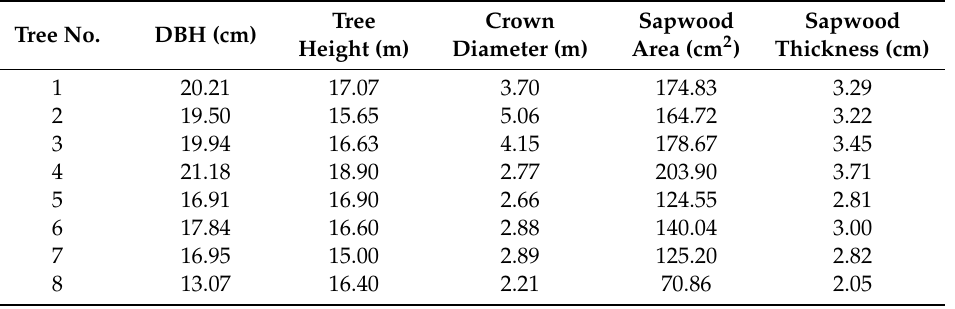
Tree Crown Sapwood Sapwood Height (m) Diameter (m) Area (cm 2 ) Thickness